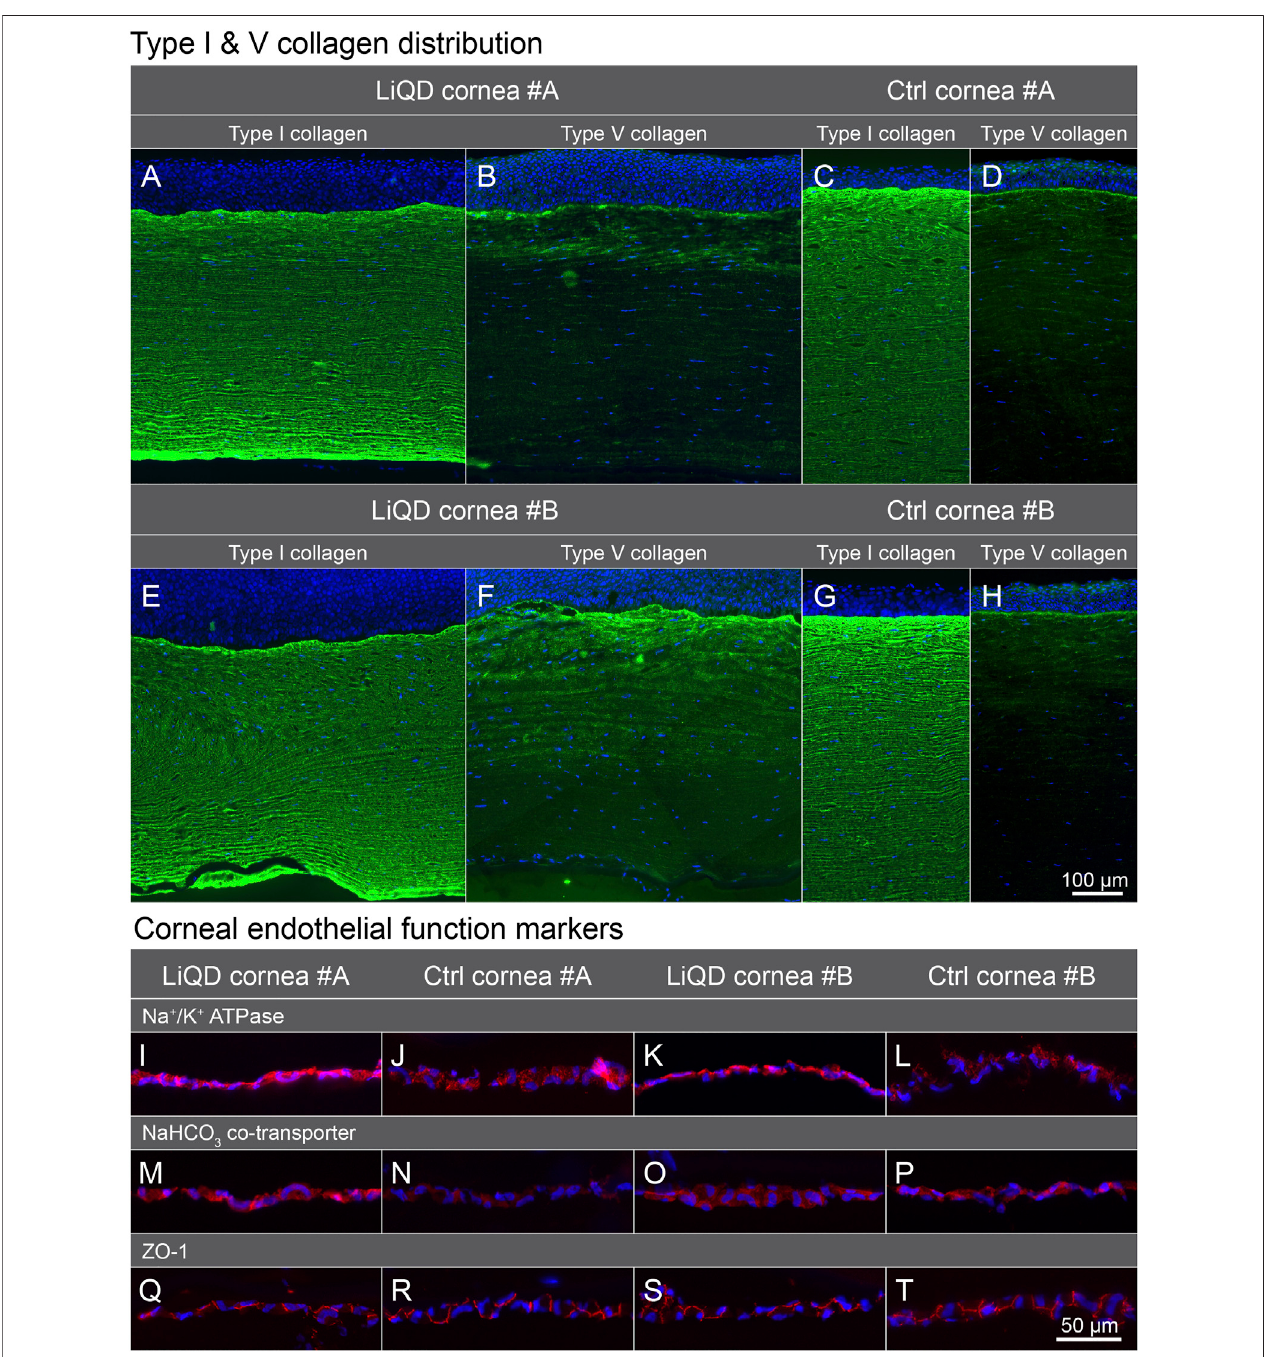
FIGURE 8 | Immuno fl uorescence labeling. Type I and type V collagen in the LiQD cornea #A (A – B) , unoperated control cornea #A (C – D) , LiQD cornea #B (E – F) , and control cornea #B (G – H) . Endothelialcell function-related proteins (I – T) : Sodium-potassium pump Na + /K + -ATPase α 1, Na + /HCO 3 cotransporter, and tightjunction complex protein ZO-1 were similarly distributed in the endothelium of implanted and control corneas. Cell nuclei were counterstained with Hoechst (blue). Scale bar: 100 µm (A – H) and 50 µm (I – T) .